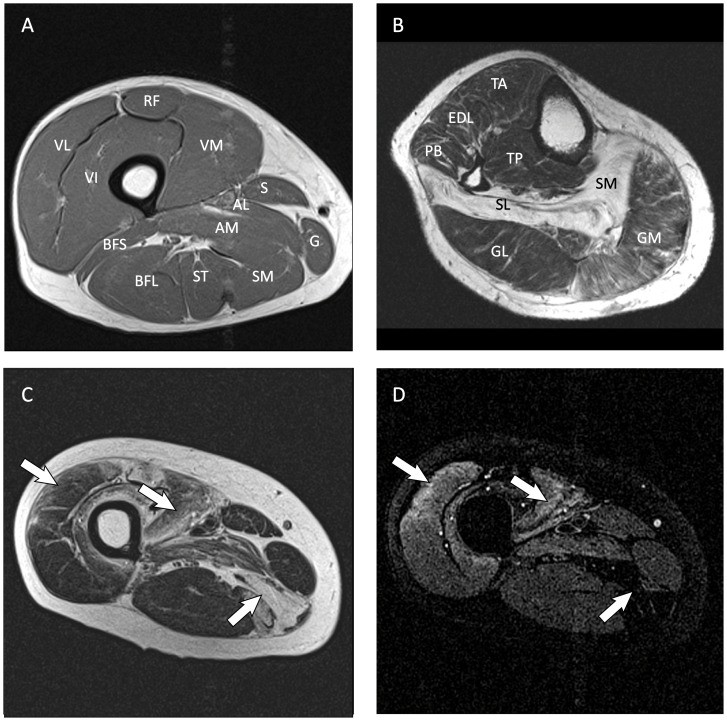
Typical transversal T1 weigthed and TIRM MR images of FSHD patients.(A) Transverse T1 weigthed image of the thigh of a male FSHD patient (age 38), showing fatty infiltration (hyperintense signal) in the semimembranosus and semitendinosus muscles. (B) Transverse T1 weighted image of the leg of a male FSHD patient (age 66 year). Fatty infiltration of the soleus muscles is clearly visible. (C) Transverse T1 weighted image of the thigh of a 39-year-old male FSHD patient. (D) Corresponding TIRM image. The semi-membranosus is clearly fat infiltrated (grey striped arrow), this results in a nulled signal on the corresponding TIRM image. In contrast, the vastus lateralis and vastus intermedius show hyperintense signal in the TIRM images (white arrows) reflecting edema or inflammation. The different muscles in the thigh (Fig. 1.A) and calf (Fig. 1.B) are indicated by the following abbreviations: rectus femoris (RF), vastus lateralis (VL), vastus intermedius (VI), vastus medialis (VM), sartorius (S), adductor longus (AL), adductor magnus (AM), gracillis (G), semi membranosus (SM), semi tendinosus (ST), biceps femoris long head (BFL) and biceps femoris short head (BFS), tibialis anterior (TA), extensor digitorum, longus (EDL), peroneus brevis (PB), tibialis posterior (TP), soleus medialis (SOM), soleus lateralis (SL), gastrocnemius medialis (GM) and gastrocnemius lateralis (GL).